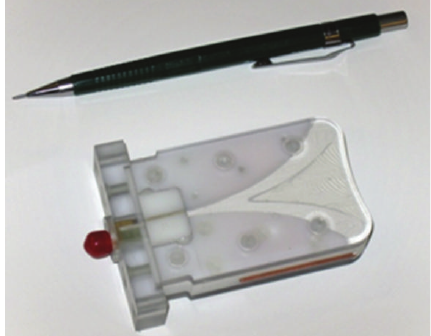
Figure 1: Cassiopeia